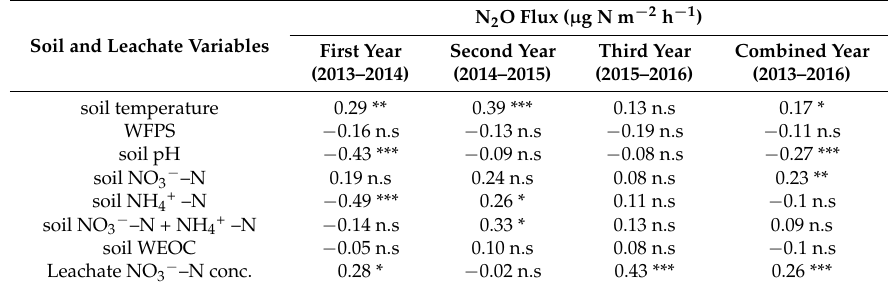
Table 3. Spearman’s correlation coefficient describing the relationship between N 2 O flux and soil and soil environmental and mineral N variables after renovation (except for winter season).